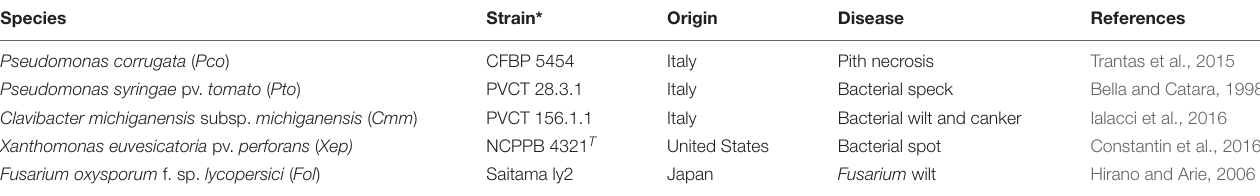
TABLE 2 | Tomato pathogens, bacteria and fungi, used in this